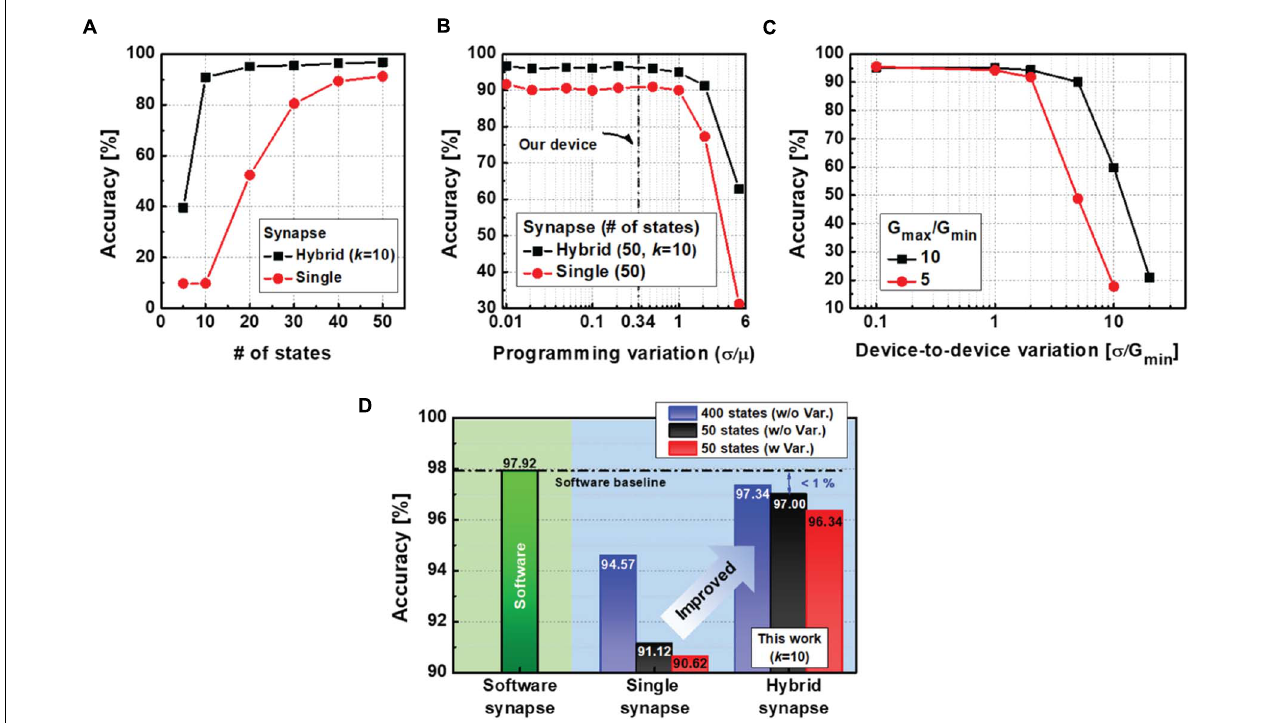
FIGURE 6 | (A) Test accuracy as a function of the number of states in an electronic device for each synapse implementation. The hybrid synapse can further improve accuracy even with a finite number of states in a device. (B) Test accuracies concerning variations in conductance changes. The proposed neural network with a hybrid synapse has good resistance to variations and enough margin for the variations of our device. (C) Test accuracies with various device-to-device variations. (D) With the proposed hybrid scheme, neural networks can yield a high accuracy of 97% with only 50 states of the electronic device. When the number of conductance states in the device increases to 400, the neural network accuracy can be improved up to